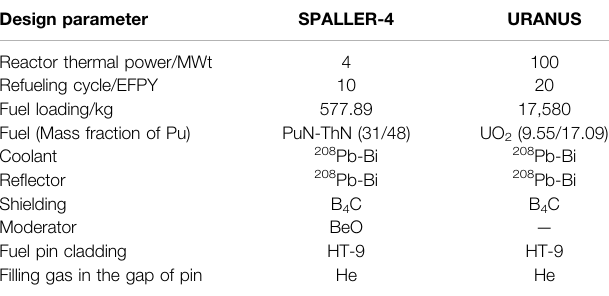
TABLE 2 | Design parameters of SPALLER-4 and